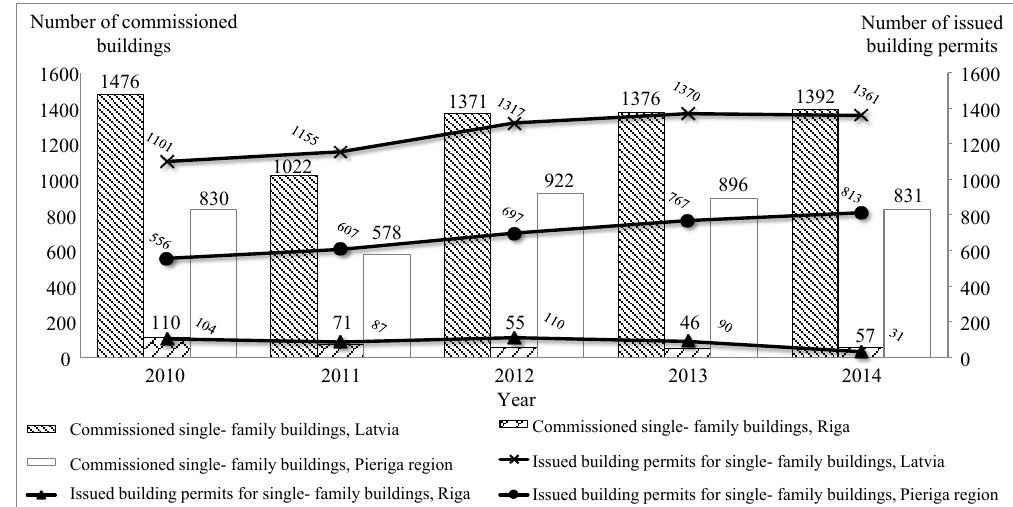
Fig. 4. The number of building permits issued and newly erected residential buildings commissioned during the period of 2010–2014 in Latvia, Riga and Pieriga statistical region (CSP, 2015 ef ) [Figure made by the authors].